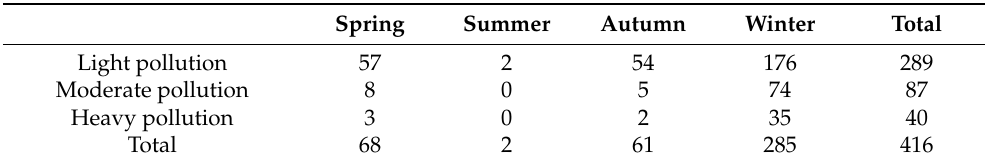
Table 3. Annually and seasonally accumulative frequencies (days) of different PM 2.5 pollution levels in Wuhan over